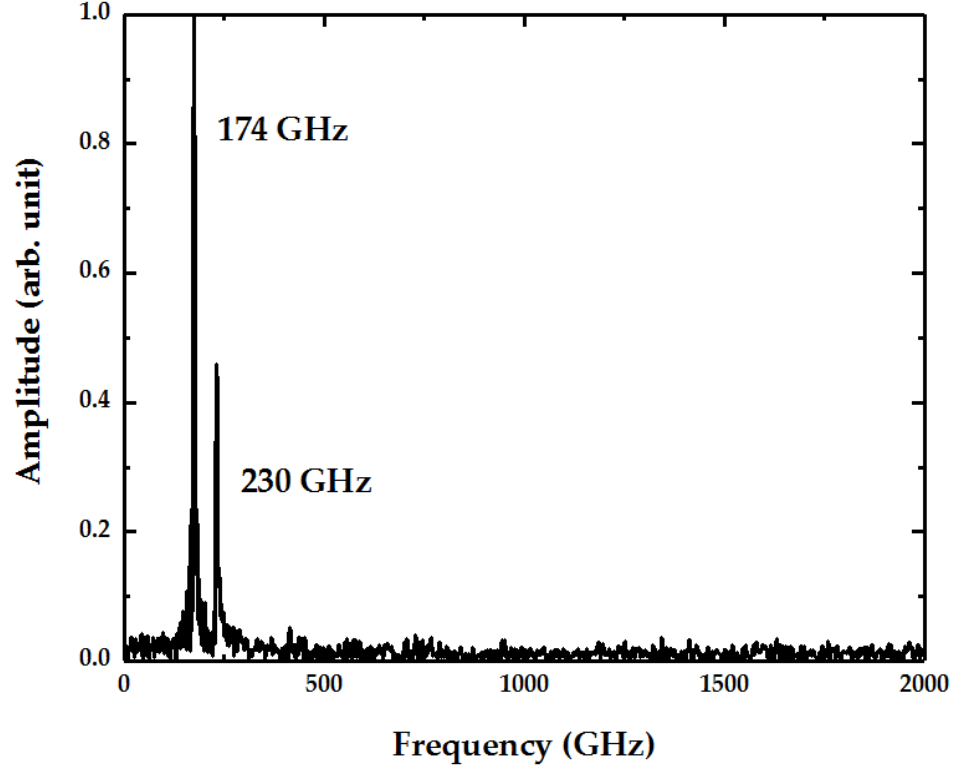
Figure 2. Normalized fundamental spectrum of kinetic energy for a doubly clamped graphene sheet with a length of 100 Å and a width of 50 Å.